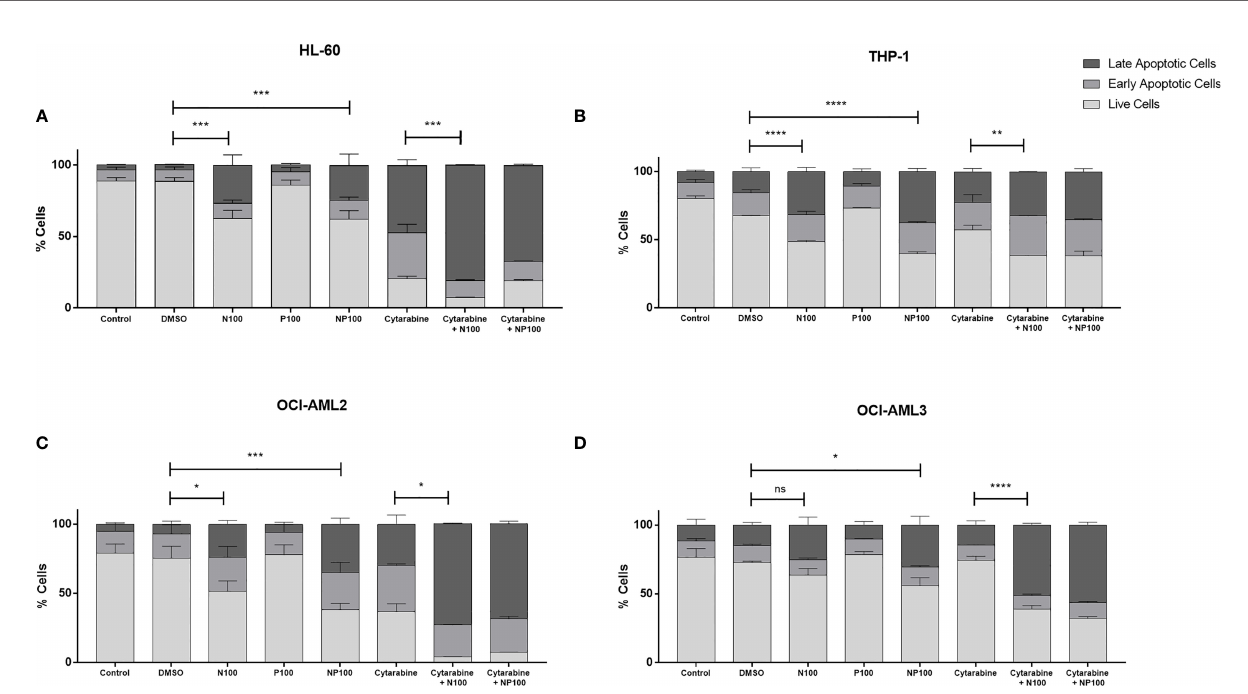
FIGURE 3 | Pro-apoptotic effect of treatment with nimesulide, prednisolone, and cytarabine. Bar graph showing the percentage of apoptotic cells in each cell line. (A) HL-60, (B) THP-1, (C) OCI-AML2, and (D) OCI-AML3 after treatment with the drugs alone and in combination for 24 h. The data presented are representative of 2 independent experiments and presented as mean ± SEM (n = 5). The p-value was determined using the two-way ANOVA multiple comparisons with Turkey ’ s correction, *p < 0.05; **p < 0.01; ***p < 0.001; ****p < 0.001. Control: non-treated cells; DMSO: treated with DMSO (dilution vehicle); N100: nimesulide 100 µM; P100: prednisolone 100 µM; NP100: combination of nimesulide and prednisolone 100 µM; Cytarabine: treated with cytarabine 2.5 µM; Cytarabine+N100; combination of nimesulide 100 µM and cytarabine 2.5 µM; Cytarabine+NP100: combination of nimesulide and prednisolone 100 µM and cytarabine 2.5 µM. DMSO, dimethyl sulfoxide. ns, not signi fi